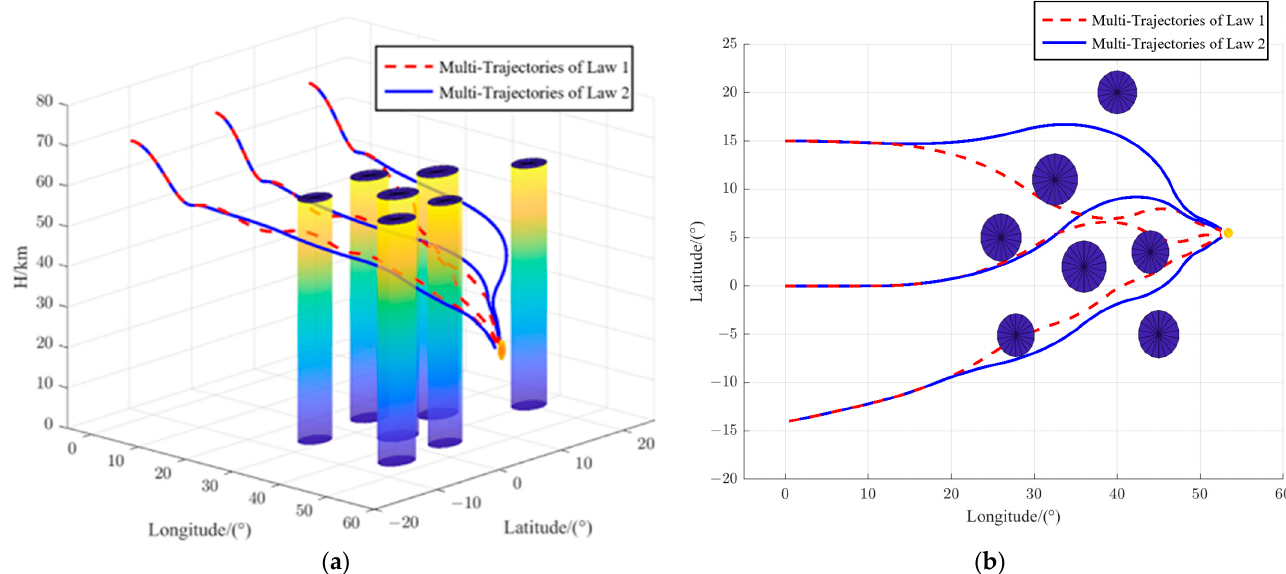
Figure 11. Simulation results of time cooperative guidance Law 1 and Law 2. ( a ) The three-dimensional trajectories of three vehicles in Law 1 and Law 2; ( b ) horizontal trajectories of multiple vehicles in Law 1 and Law 2. Table 4. Terminal states of time cooperative guidance Law 1 and Law 2.